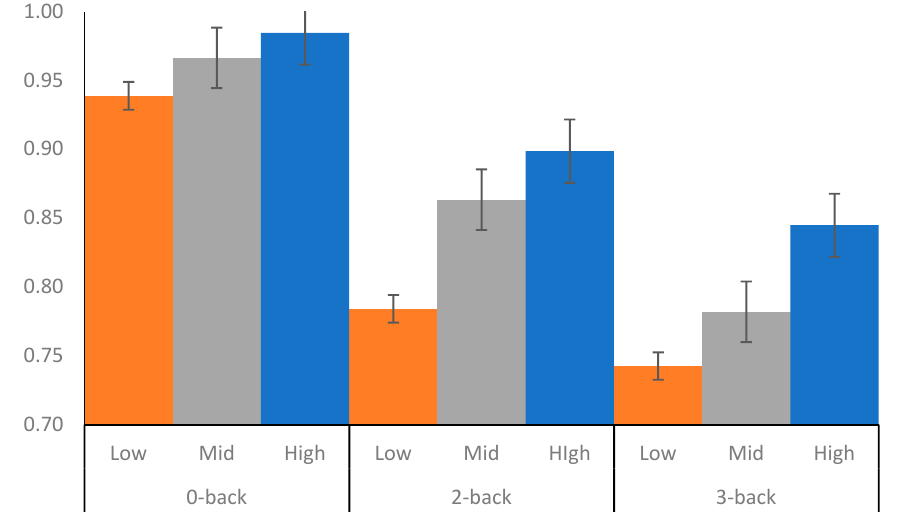
Figure 2. Accuracy According to Emotional Reasoning Group in Study 1; Note: Error bars are standard errors of the mean.